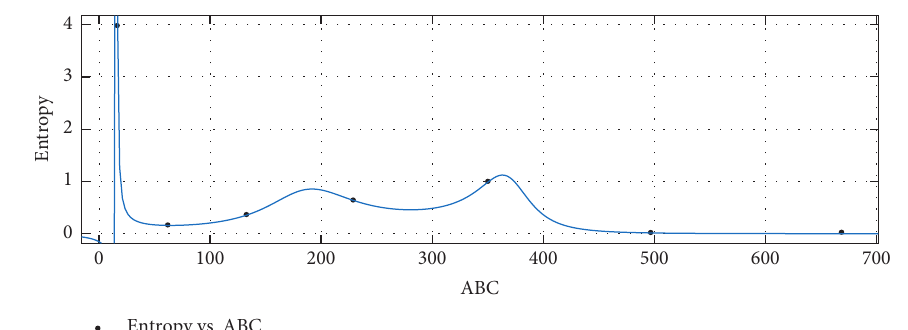
Figure 15: ABC ( x -axis) versus Ent ( y -axis).